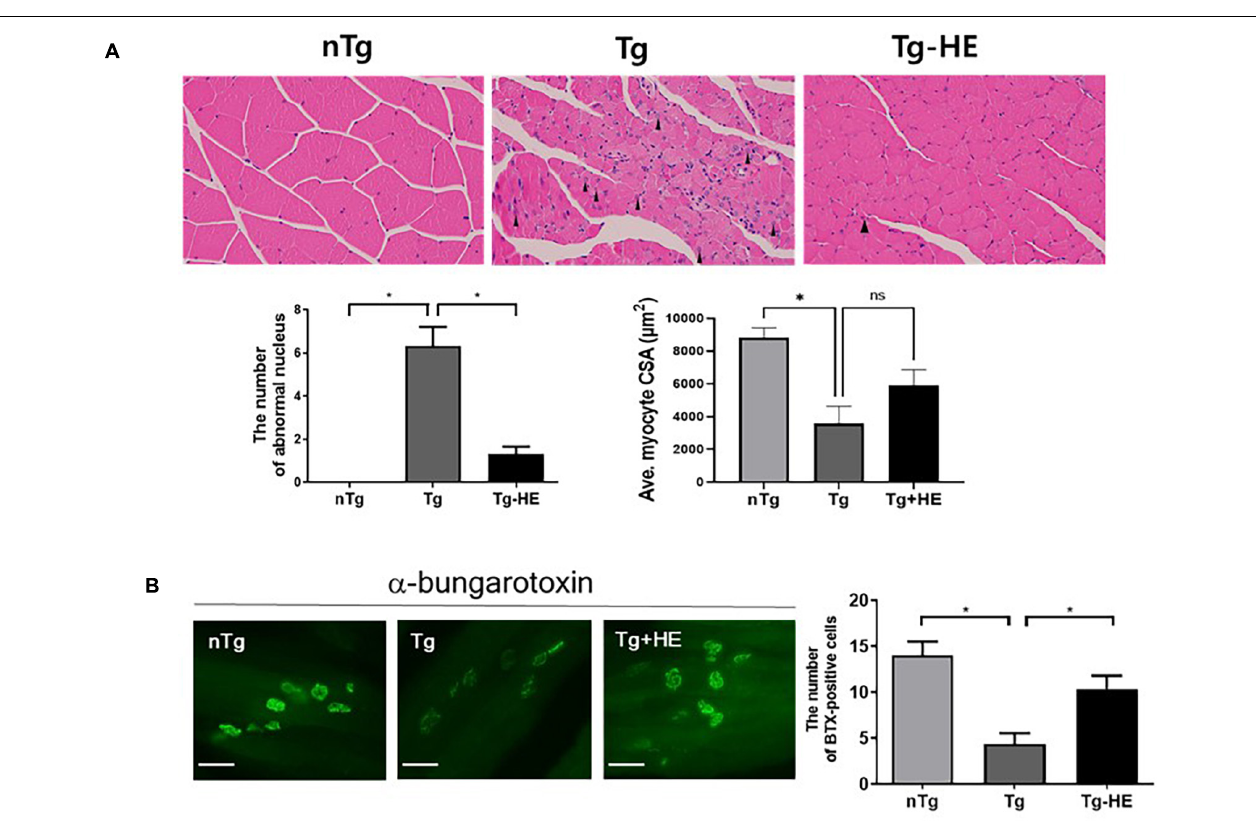
FIGURE 5 | Herbal extract (HE) prevents muscle degeneration in the gastrocnemius (GC) of hSOD1 G93A mice. (A) Representative images of H&E staining of the GC of the nTg, Tg, and Tg-HE groups and quantification of the number of abnormal of nucleus and myocyte cross-sectional area (CSA). The arrowhead indicates an abnormal nucleus. (B) α -bungarotoxin staining of the GC and quantification of the number of BTX-positive cells ( N = 3); scale bar = 500 µ m. Data are shown as the mean ± SEM. The statistical analyses were conducted with a one-way ANOVA followed by Bonferroni’s multiple comparison tests (* p <